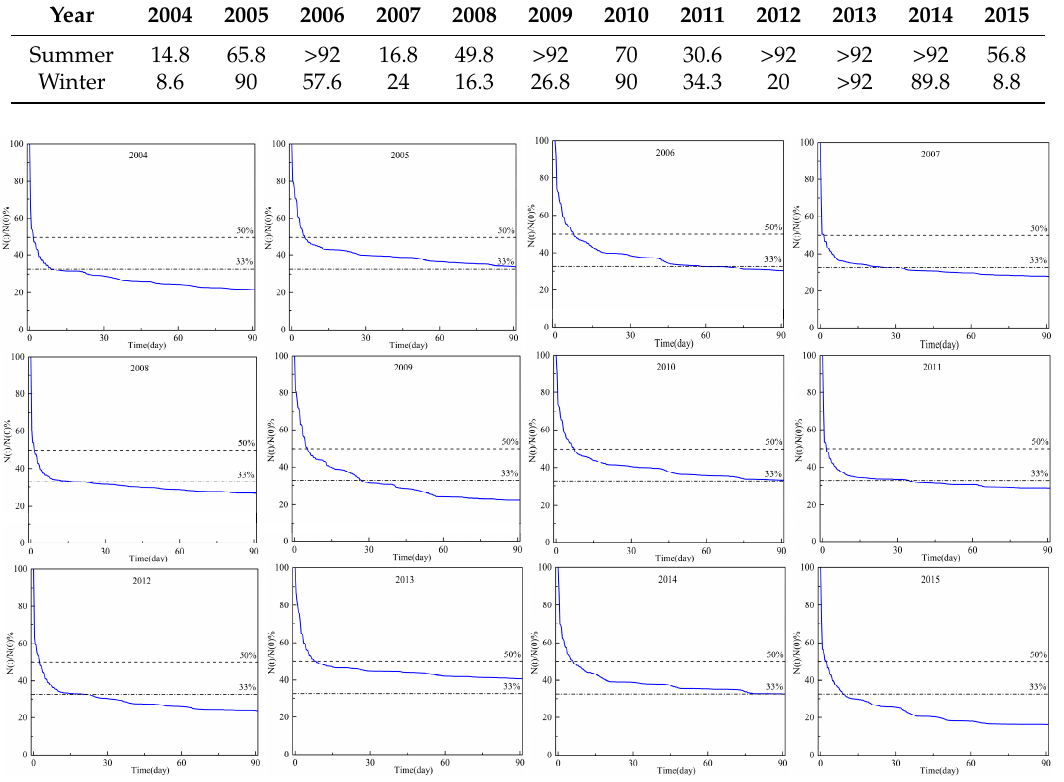
Table 3. The mean residence time (i.e., 33% of the initial particles remaining in the bay) of Tieshangang Bay in summer and winter (2004–2015).